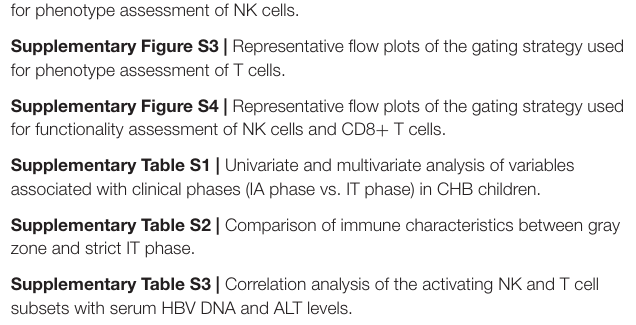
Supplementary Figure S1 | Frequencies and absolute number of NK cells, CD4 + and CD8 + T cells in different clinical phases.